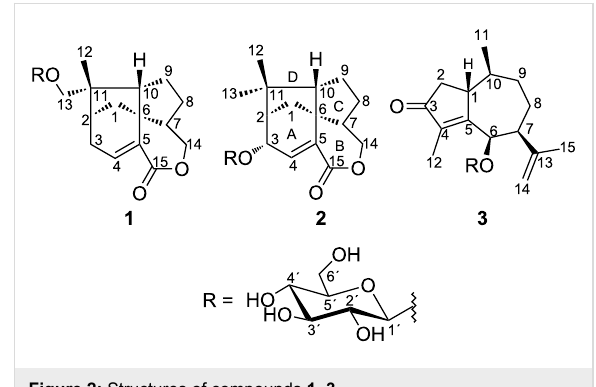
Figure 2: Structures of compounds 1 – 3